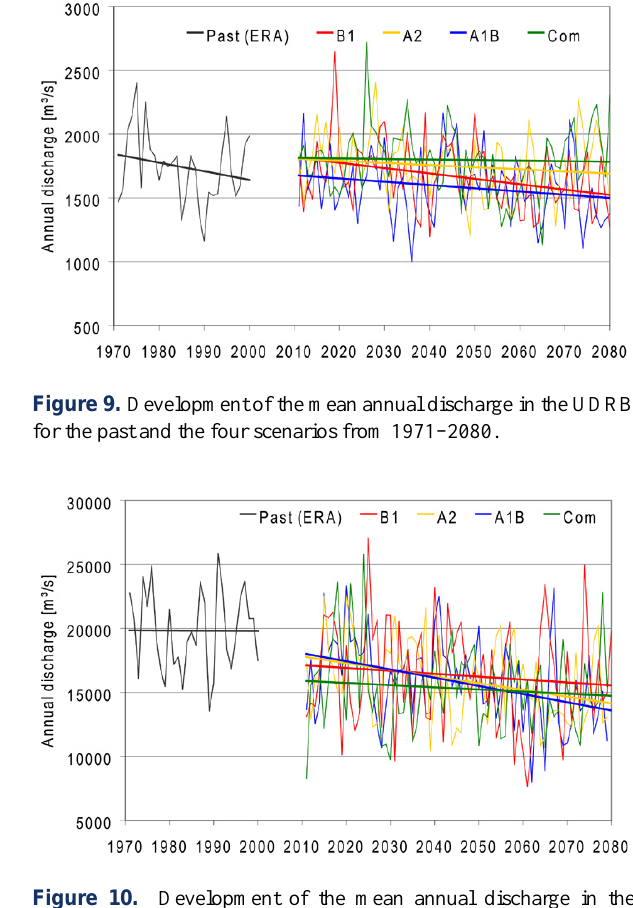
Figure 10. Development of the mean annual discharge in the UBRB for the past and the four scenarios from